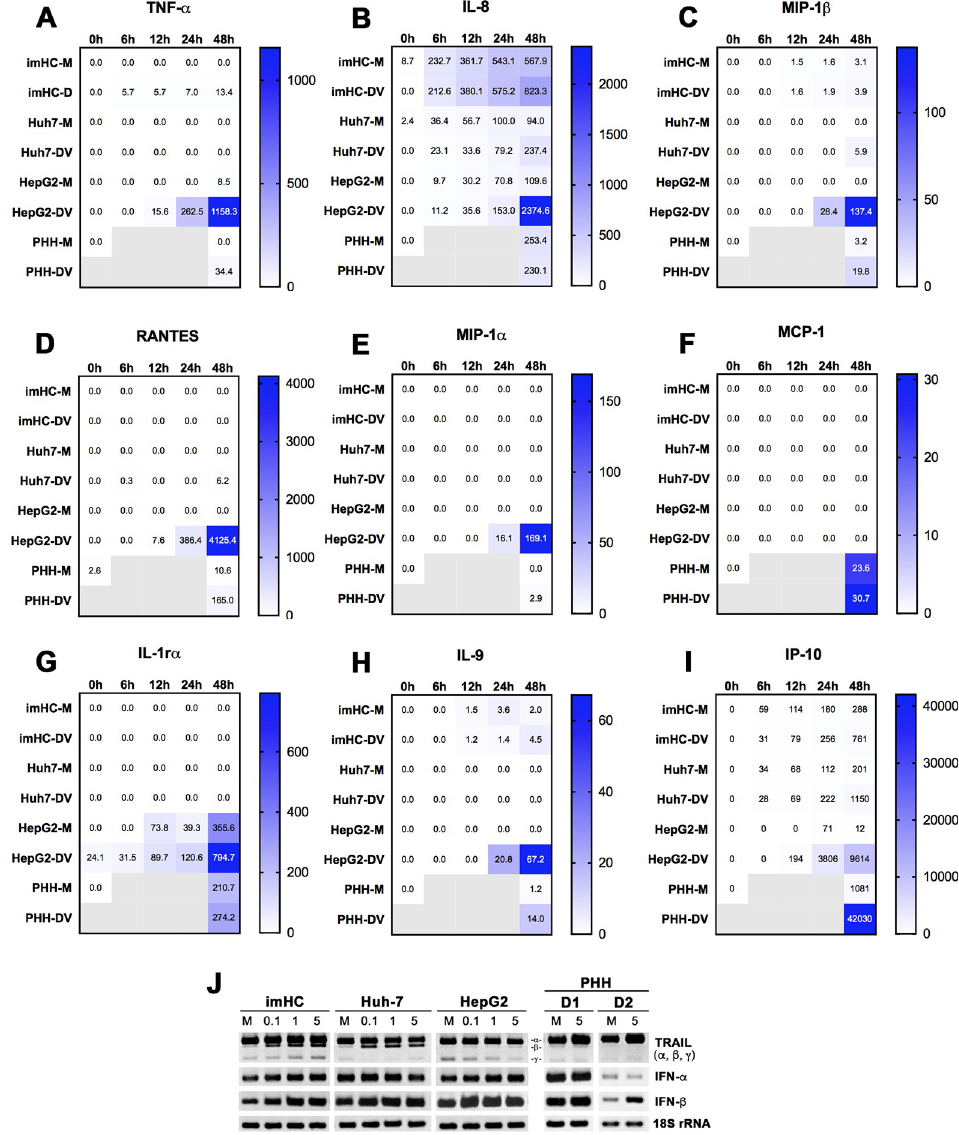
Fig 5. Cytokine expression of hepatocytes upon DENV-2 infection. The three hepatic cell lines and PHHs from 2 different donors (D1 and D2) were mock-infected (M) or infected with DENV-2 (DV) at MOI of 5. At the specified time points, cells and culture supernatants were harvested for assessment of cytokine expression. ( A-I ) A heatmap of differential cytokine protein production by hepatic cell lines and PHHs was quantified by Bio-Plex Pro Human Cytokine 27-plex assay. The numbers shown in the heatmap are average amounts (pg/ml) of secreted cytokines from two experiments of hepatic cell lines or two donors for PHHs. An equal number of each cell type was used for RNA extraction and an equal amount of RNA from each source was further subjected to RT-PCR and gel electrophoresis. The three hepatic cell lines and PHHs from 2 different donors (D1 and D2) were mock-infected (M) or infected with different MOIs (0.1, 1 and 5) of DENV-2. The cells were harvested for RT-PCR analysis of TRAIL, IFN- α , and IFN- β and a representative gel, showing RT-PCR products corresponding to these cytokines, is shown in J . DENV-induced up-regulation of MIP-1 α (at 48 hpi) was detected in all cell types at the gene level ( S5 Fig ). However, secreted MIP-1 α protein was only measurable in HepG2 and PHHs ( Fig 5E ). Unlike PHHs, MCP-1 secretion was not detectable in any cell line ( Fig 5F ); however, its induction following 48h-DENV infection was observed at the gene level in imHC ( S5 Fig ).